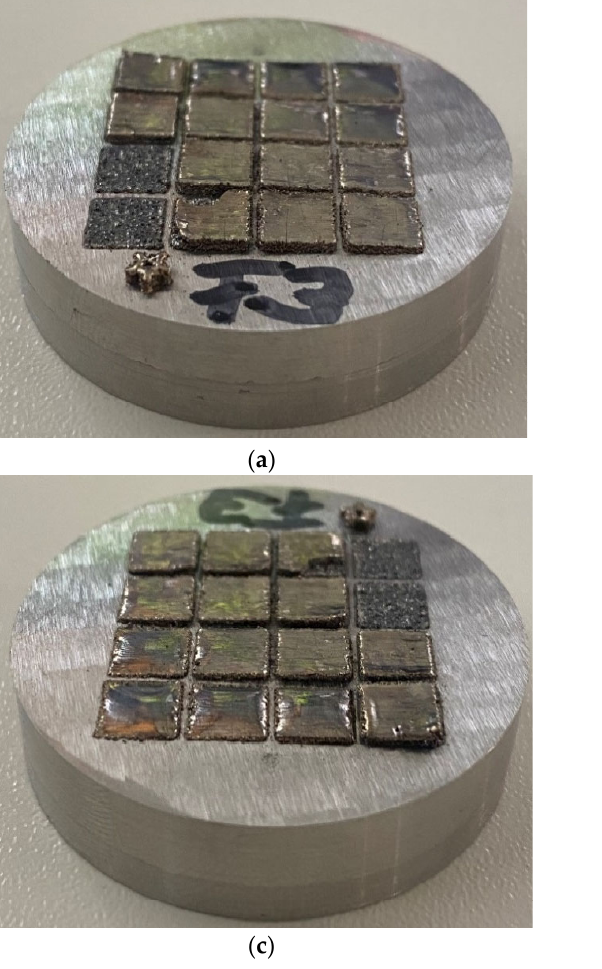
Figure 5. PBF-LB samples of parameter study (parameter setting detailed in Figure 3b); the star icon marks the machine front: ( a ) front view, ( b ) view from right side, ( c ) back view, ( d ) view from left side.